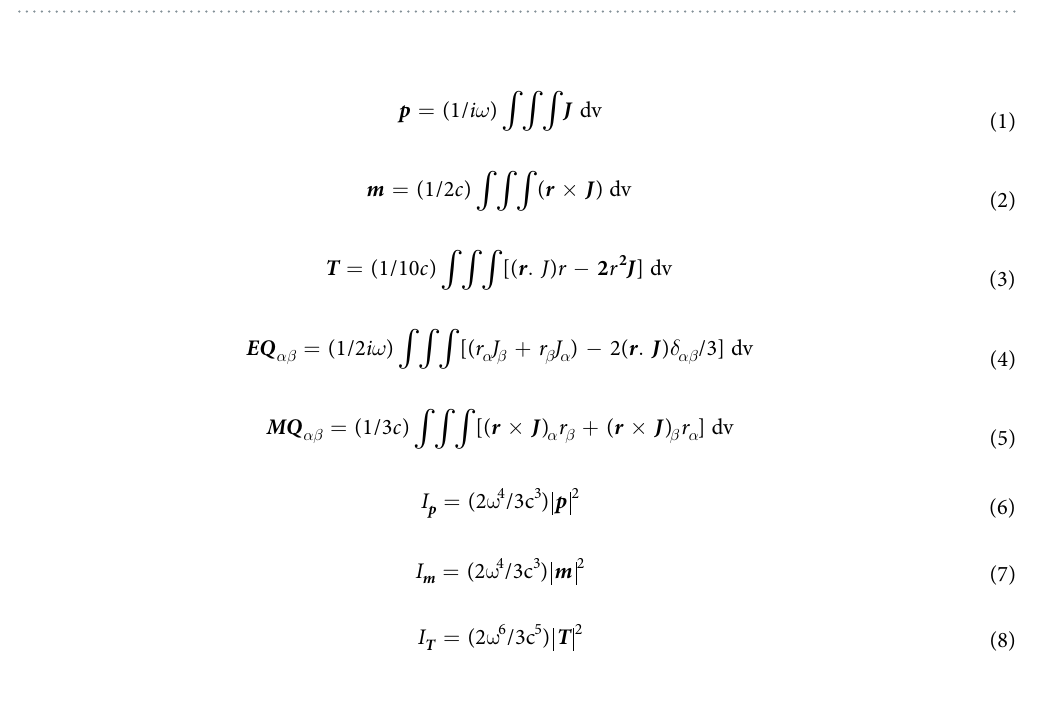
Figure 2. ( a ) Reflection and absorption spectra of toroidal metamaterials at normal incidence. ( b , c ) Magnetic field distributions on the xy plane across the center of SiO 2 spacer, at the resonance frequencies of f 1 and f 2 . Red arrows show the directions of magnetic fields, and colors give the intensity of magnetic fields. Geometrical parameters: d = 150 nm, h = 50 nm, t = 30 nm, R = 120 nm, θ = 120°, p x = p y = 500